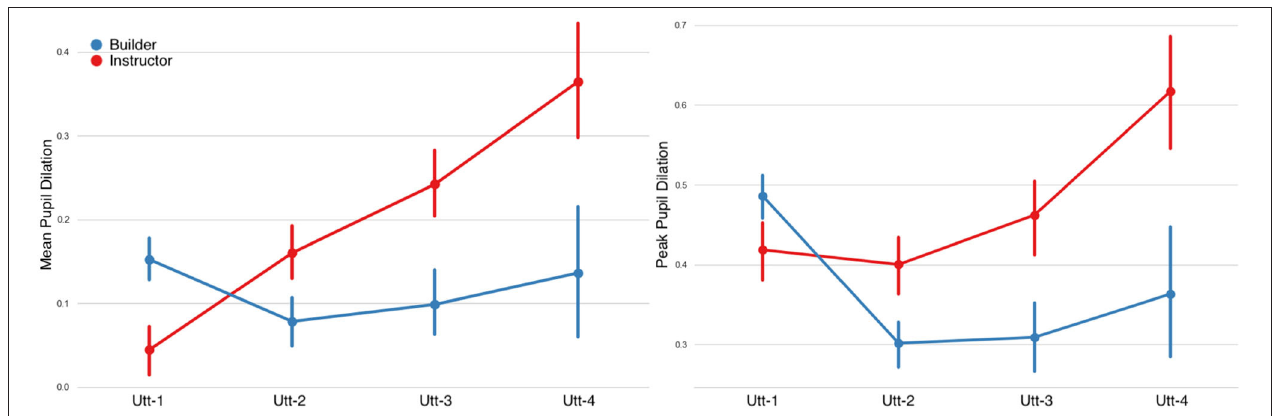
FIGURE 12 | Pupil dilation (in mm) per utterance sequence. Mean Pupil Dilation on the left and Peak Pupil Dilation on the right. An interaction effect can be observed in both measures. Error bars indicate standard error of the